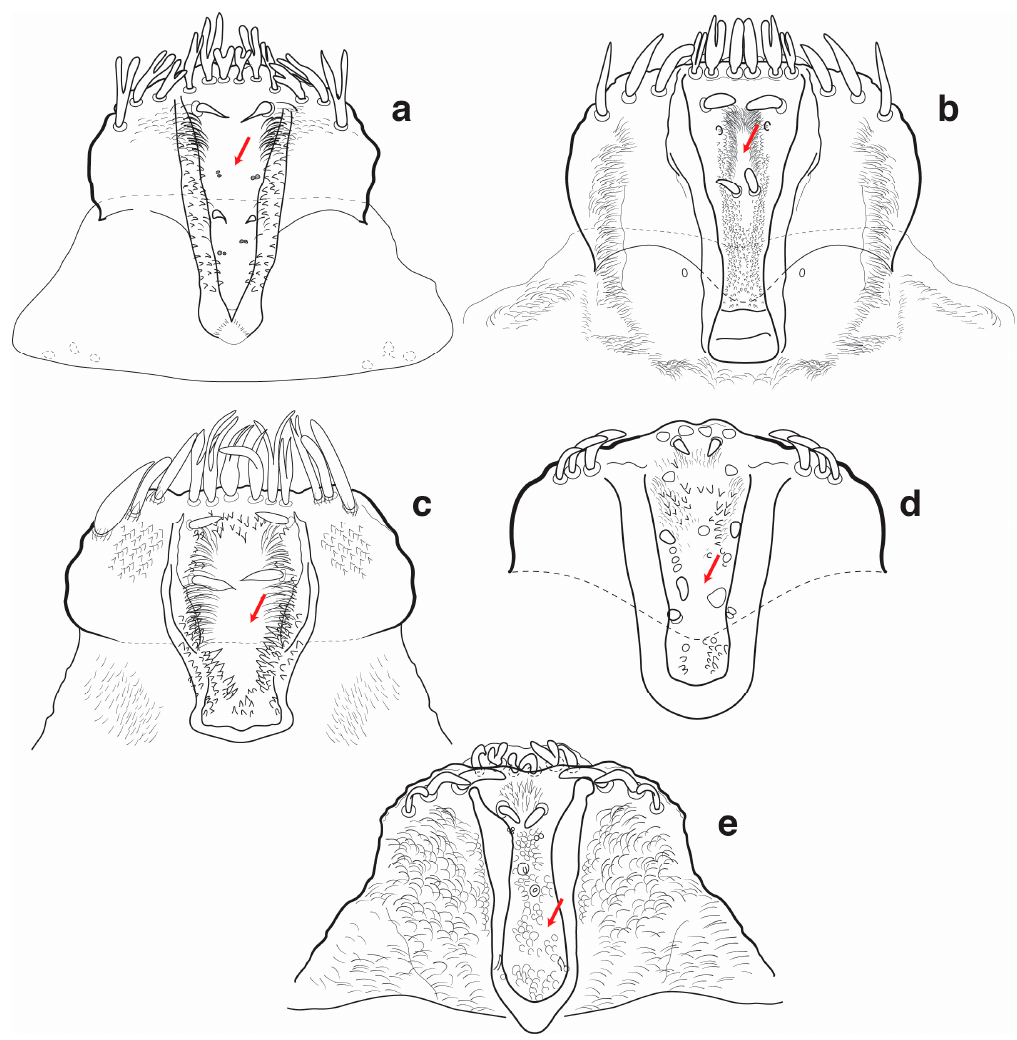
Figure 24. Epipharynx, larva: ( a ) Eucalandra ; ( b ) Metamasius ; ( c ) Temnoschoita ; ( d ) Stenommatus ; and ( e ) Trochorhopalus . 11. Number of anterolateral epipharyngeal setae (als) (Figure 25)